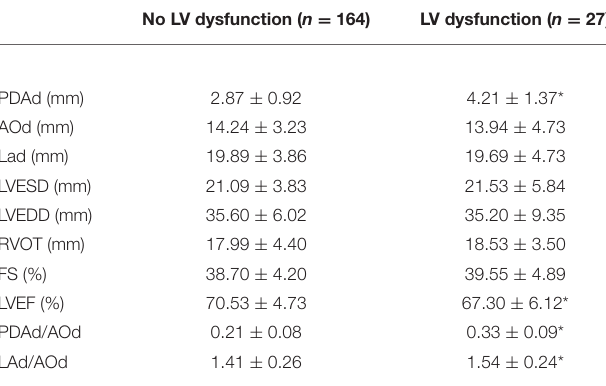
TABLE 3 | Comparison of pre-closure echocardiography parameters in patients with or without post-closure LV systolic